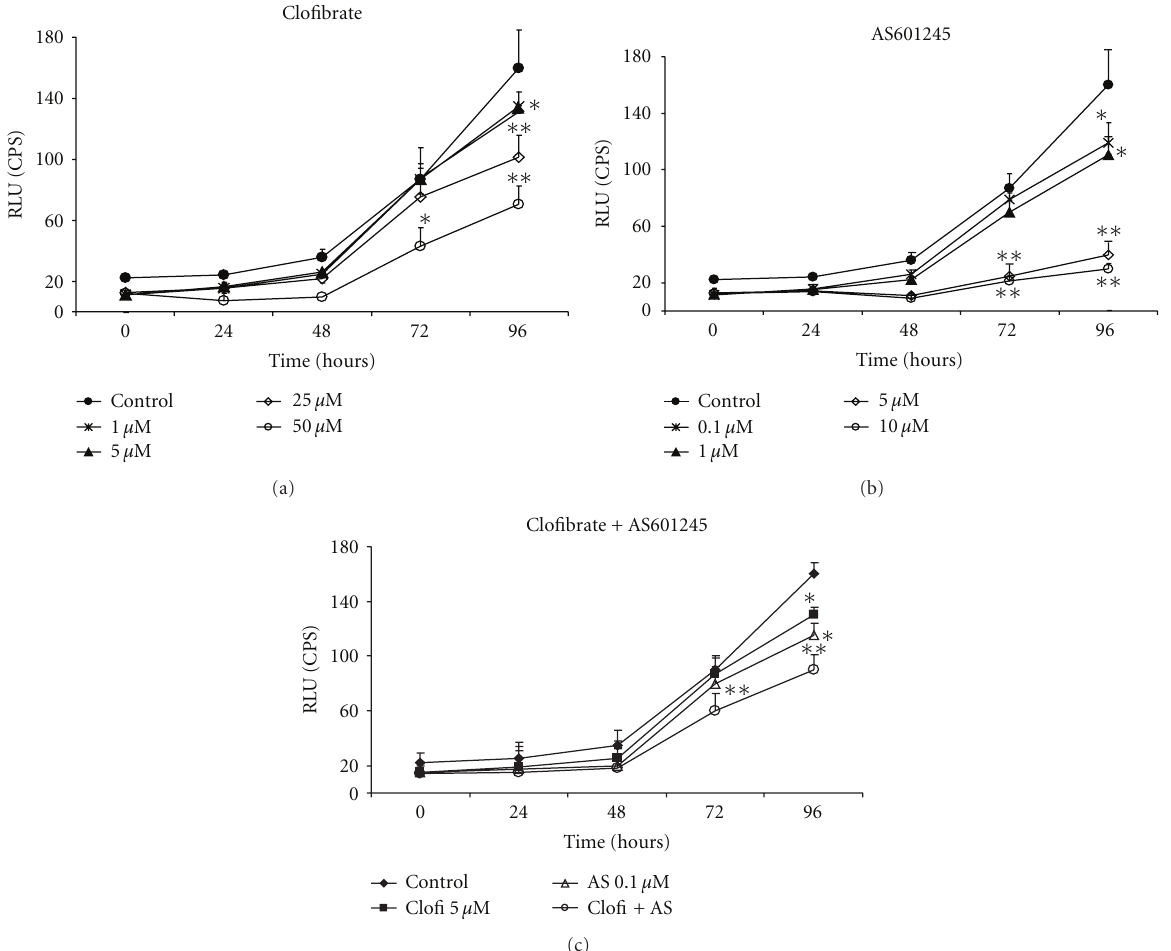
Figure 1: Caco-2 cell proliferation. (a) Growth of Caco-2 cells treated with clofibrate at the indicated concentrations (from 1 to 50 μ M) and at di ff erent times; (b) growth of Caco-2 cells treated with AS601245 at the indicated concentrations (from 0,1 to 10 μ M) and at di ff erent times; (c) growth of Caco-2 cells treated with 5 μ M clofibrate, 0,1 μ M AS601245, and the association of these two compounds (Clofi + AS601245). Cell proliferation was detected by measuring the luminescence released by the metabolically active cells. The values expressed in RLU (relative light units) are the means ± SD of three separate experiments. Variance analysis: ∗ P < 0 . 05, ∗∗ P < 0 . 01 versus control.